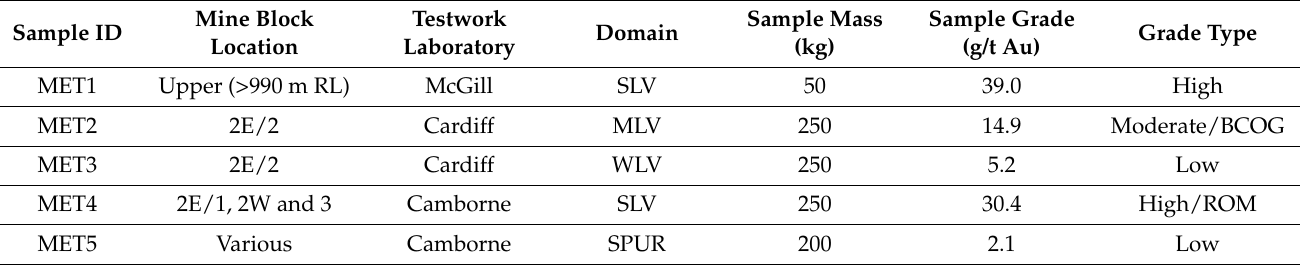
Table 7. Overview of MET samples collected and tested as part of this study. SLV: strongly laminated vein with abundant visible gold; MLV: moderately laminated vein with minor visible gold; WLV: weakly laminated vein with minor visible gold.